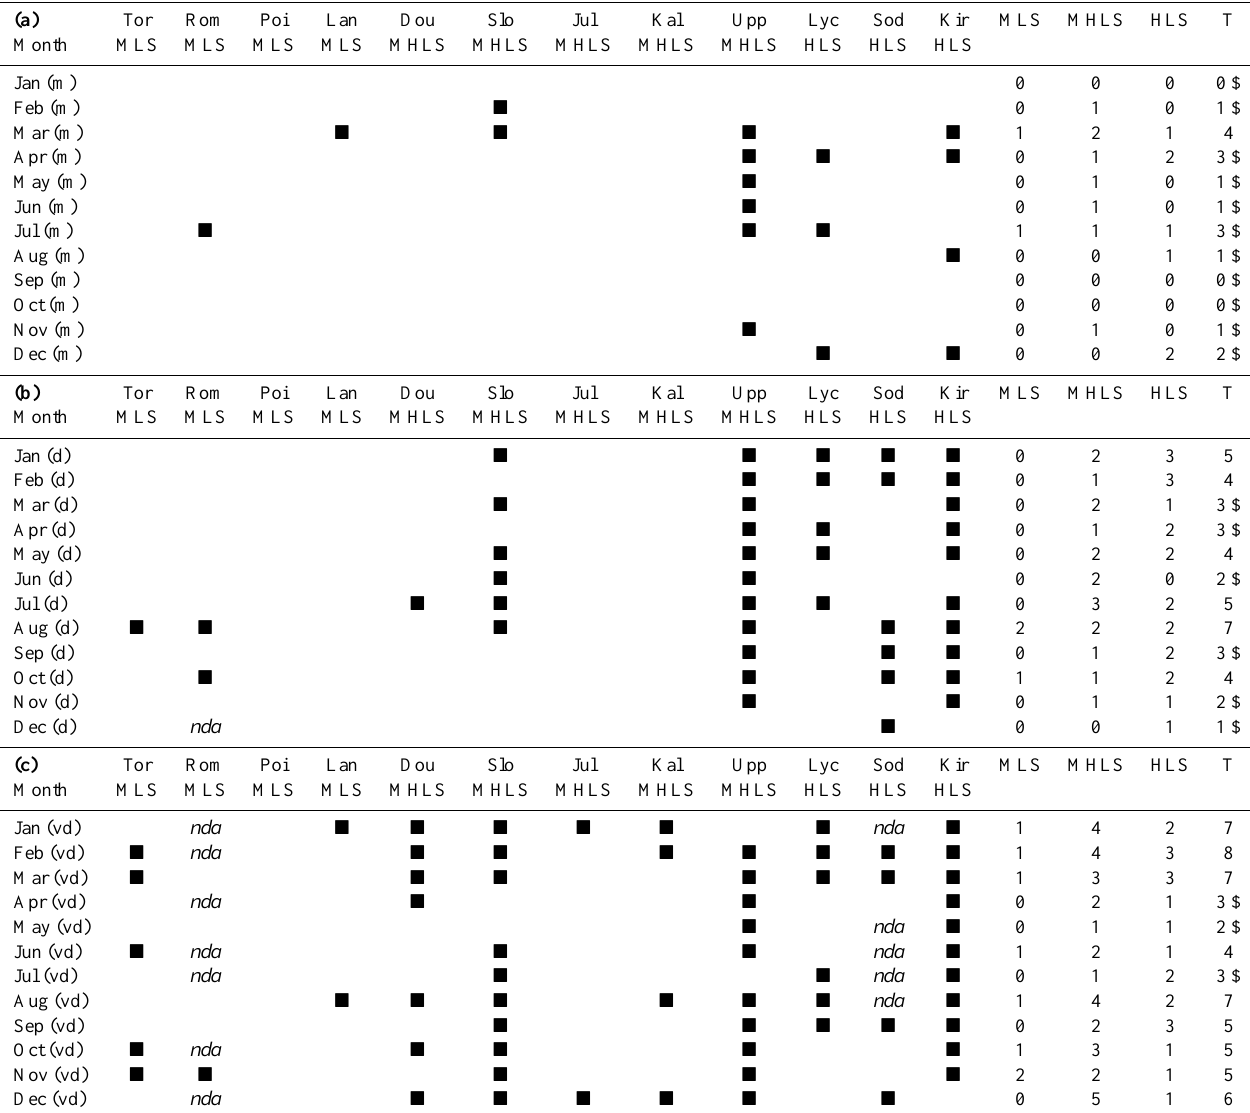
Table 5. Same as Table 2 but for the sites where the best performance is provided by the prediction model (5), indicated with the square. The term nda indicates the cases for which it was not possible to evaluate the performance of the prediction model (5) with respect to the other models because no data were available to calculate the g.r.m.s.